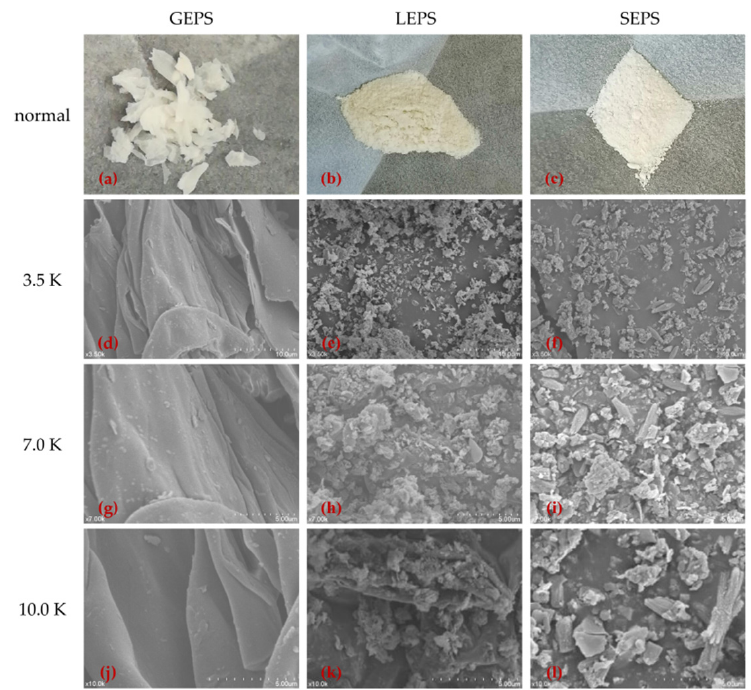
Figure 2. The appearance and scanning electron microscopy (SEM) images of EPSs at different magnifications (3.5, 7.0, and 10.0 K). ( a ) GEPS (normal); ( b ) LEPS (normal); ( c ) SEPS (normal); ( d ) GEPS